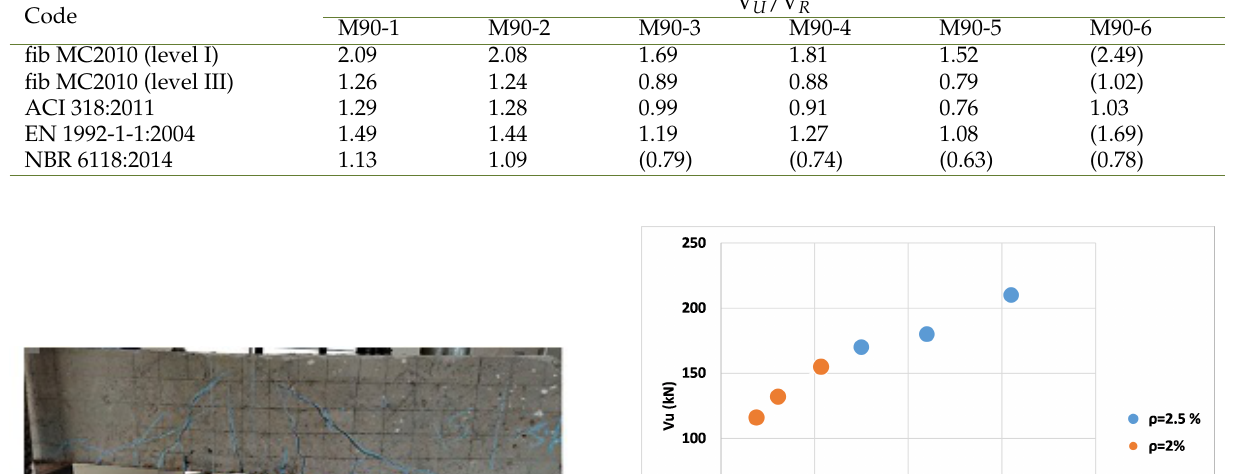
Table 7. Ratios of experimental results to calculated shear capacities using codal provisions Code